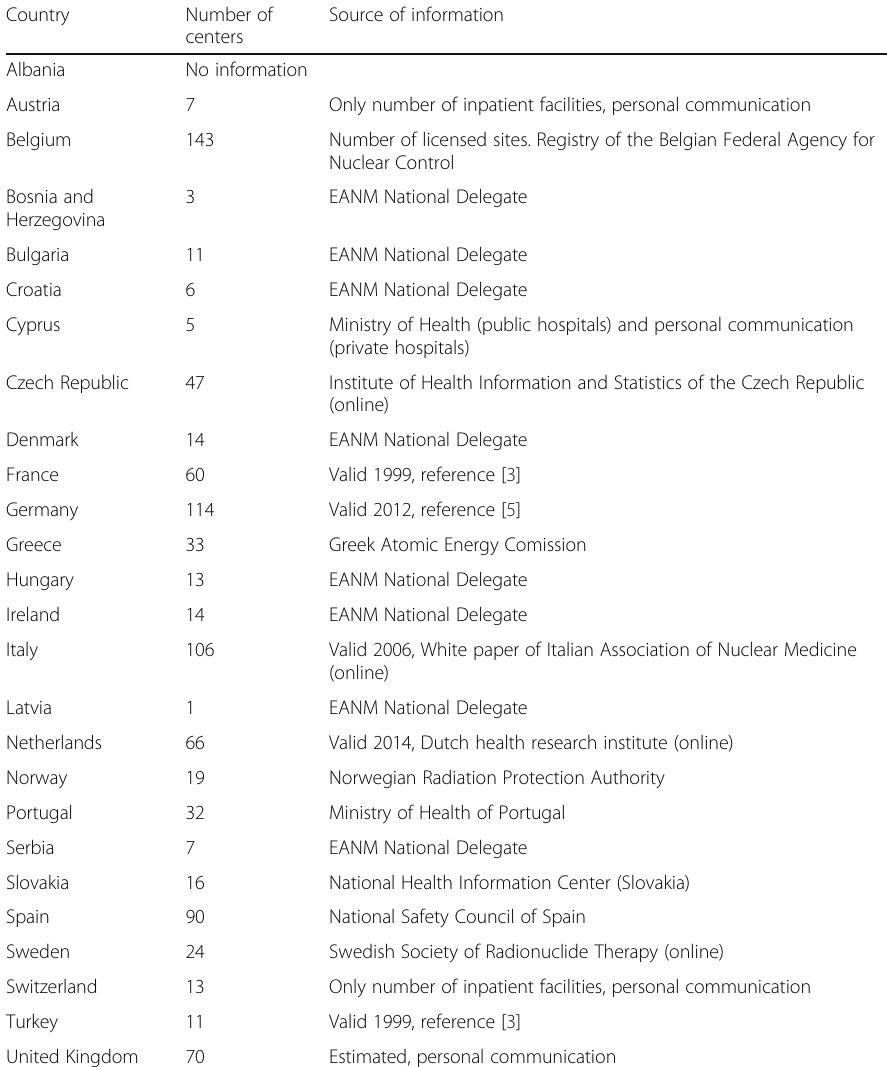
Table 5 Number of centers that administer molecular radiotherapy in the countries from where responses were obtained. Numbers have been acquired from a variety of sources, as indicated, and are valid for 2015 – 2016 except where explicitly stated otherwise Country Number of centers Only number of inpatient facilities, personal communication Number of licensed sites. Registry of the Belgian Federal Agency for Nuclear